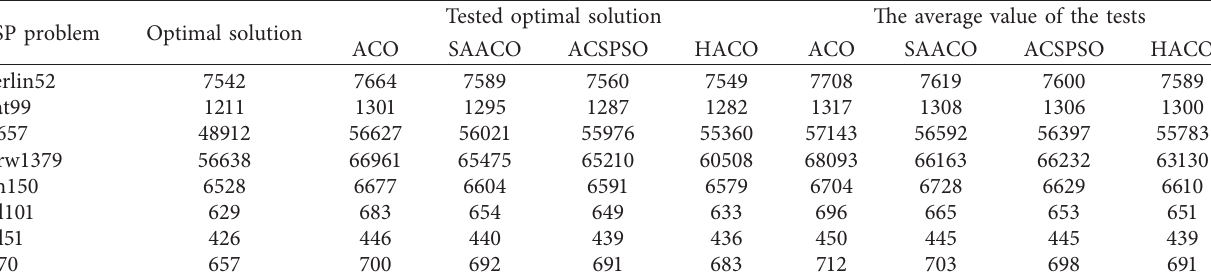
Table 1: Table of customer order information.